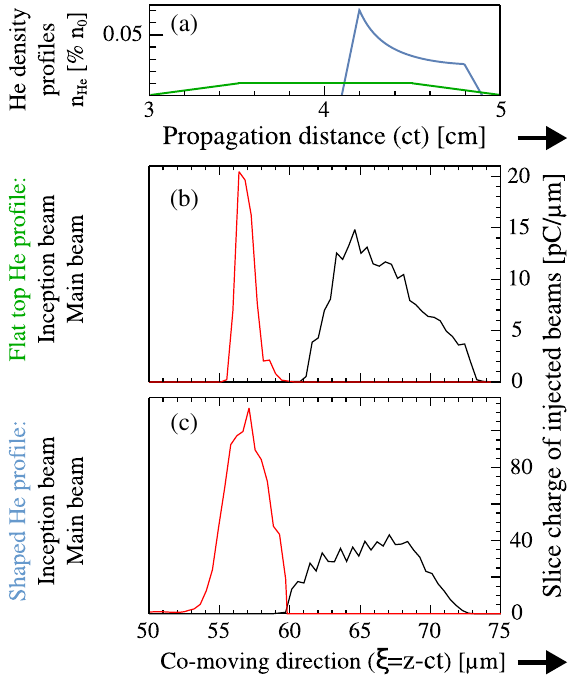
II. Control simulation He impurity parameters for the configuration with long, wide driver (FACET-I). FIG. 2. Plot of the longitudinal He impurity density profile for the simulations with flat-top (control simulation, in green), and tailored density profiles (optimized simulation, in blue). Vertical axis corresponds to the propagation distance, ct . (b) and (c) show the longitudinal slice charge at the end of the two simulations, ct ≈ 7 cm. The B-III injected main trailing beam is shown in black and the inception beam is shown in red. The slice charge scales in (b) and (c) are different, for clarity. Trailing beam propagation direction is from left to right side of the